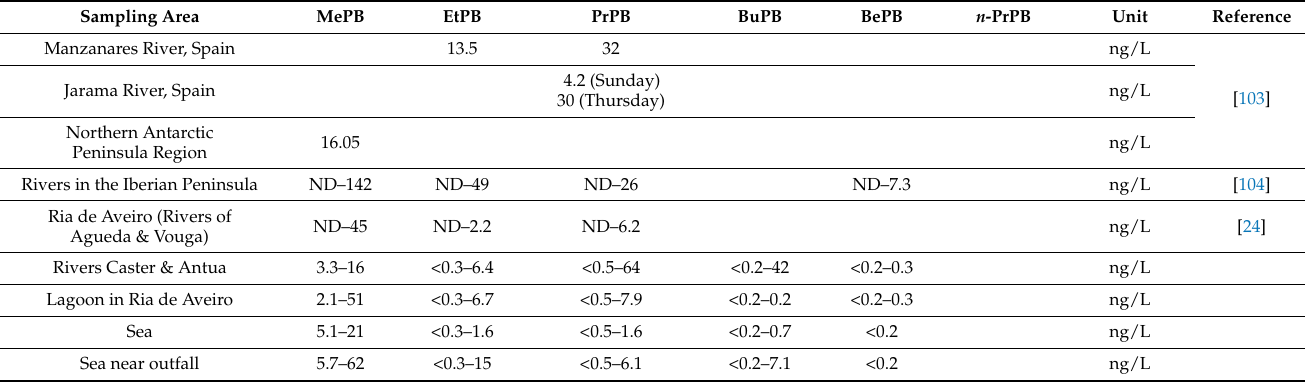
Table 1. Concentration of parabens in water, sediment, and fish and human